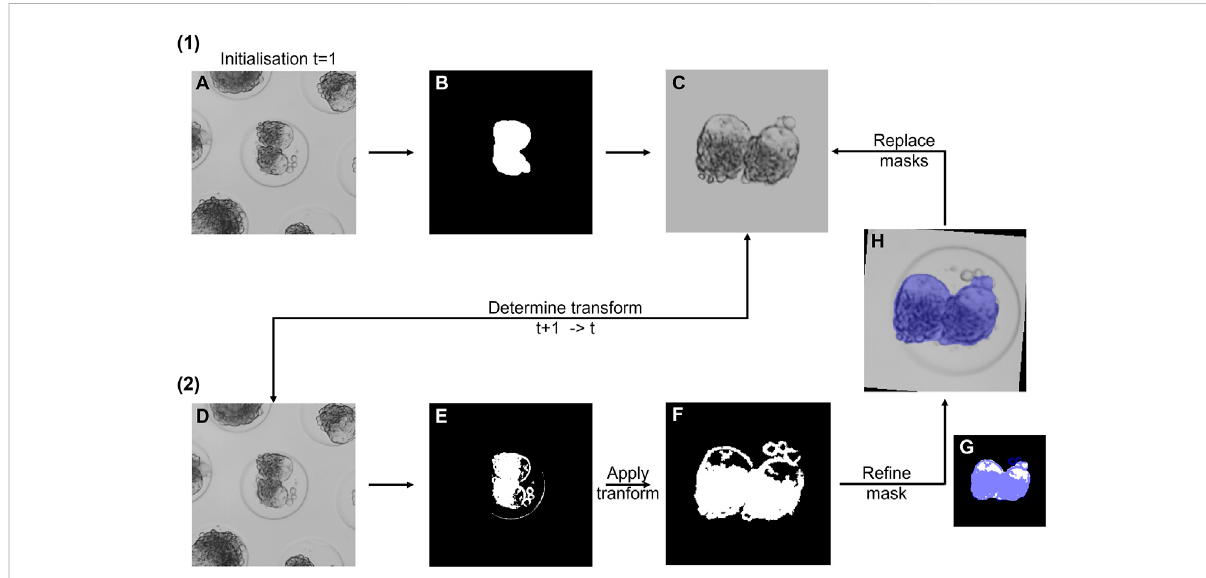
FIGURE 2 Overview of the doublet segmentation approach. (1) Initialization for frame 1. (A) Raw image. (B) Segmented mask. (C) Binary (for fi ne-tuning) andgrayscale(forregistration)mask.Onlythegrayscalemaskisshown.(2)Segmentationofconsecutiveframest+1. (D) Rawimageattimet+1.The rigid transformation was determined with respect to the stored reference mask (C) . (E) Fine doublet segmentation. (F) Transformed mask. (G) Binary referencemaskoverlaidwiththemaskin (F) . (H) Re fi nedmaskoverlaidontherawimage.Next,bothreferencemasksoftheprevioustimepoint were replaced with the new masks, and the cycle was